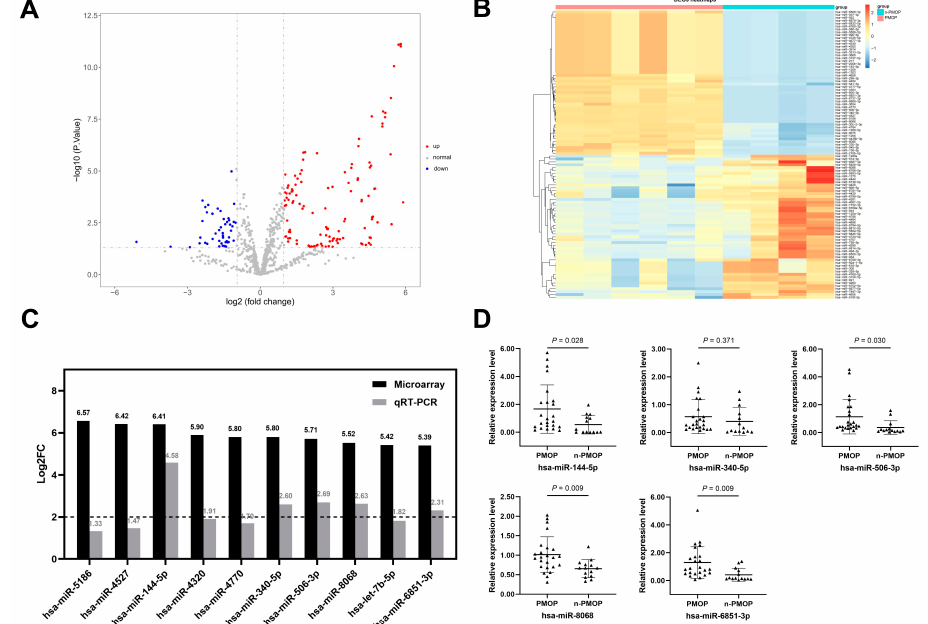
Figure 2. Screening of key miRNAs. ( A ) Volcano plot for visualization of DEmiRNAs. ( B ) Heatmap for visualization of the top 50 upregulated and downregulated DEmiRNAs. ( C ) Five candidate key miRNAs were obtained according to the screening criteria |Log2FC| ≥ 2 and p < 0.05. ( D ) Rel- ative expression levels of candidate key miRNAs in the training set. DEmiRNAs, differentially expressed